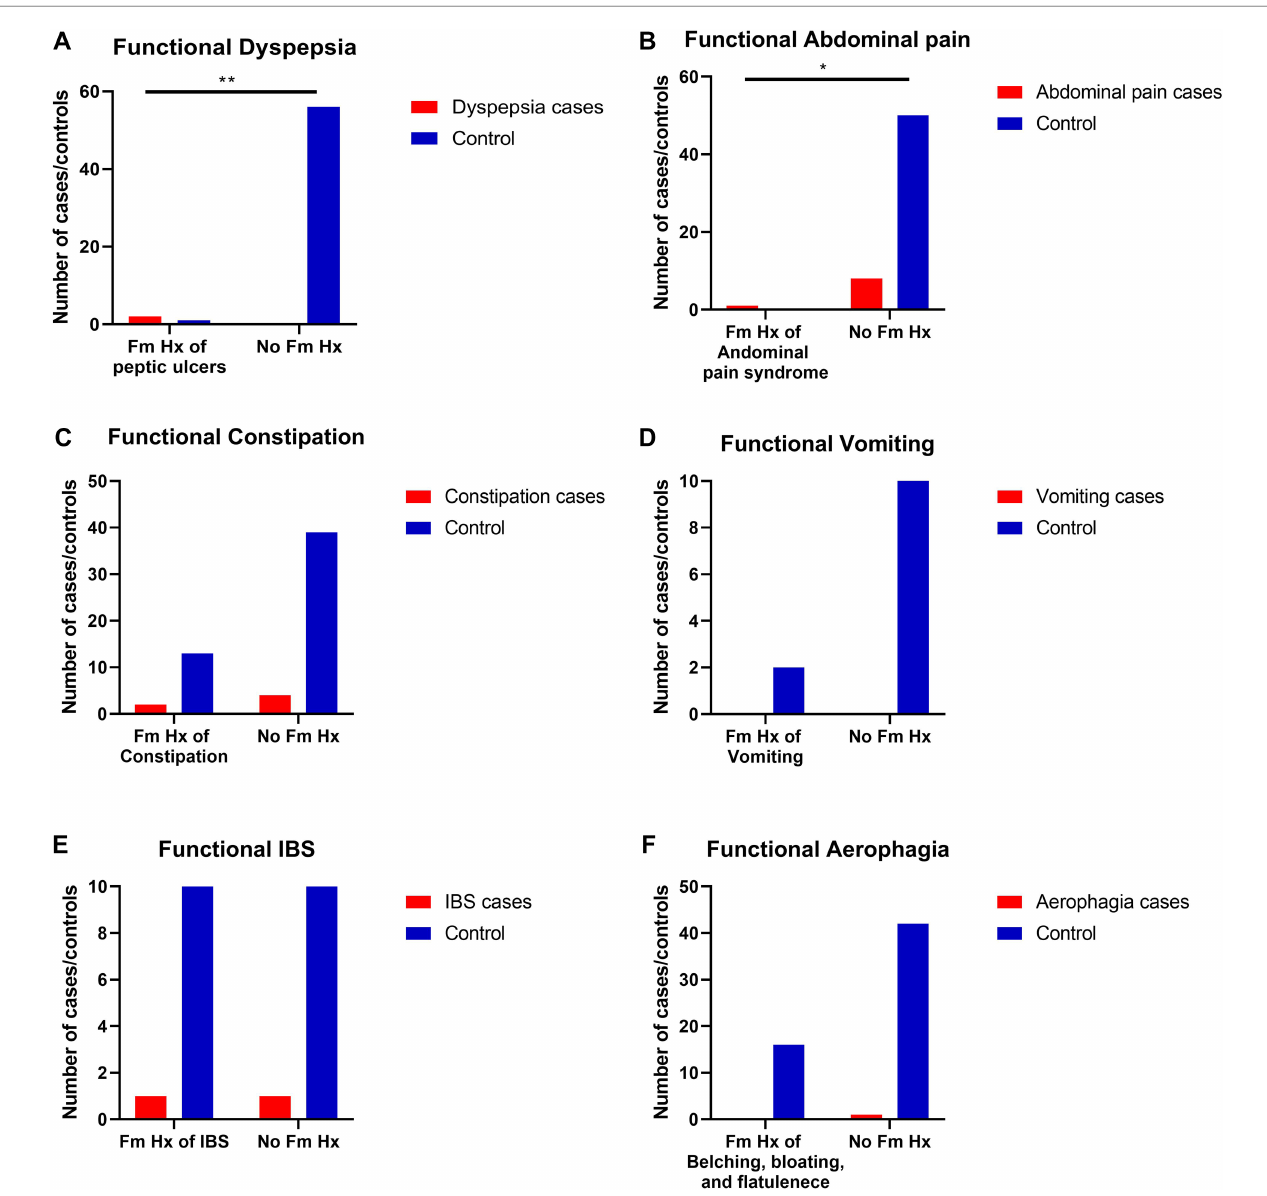
FIGURE 3 The relationship between FGIDs and some common foods consumption. Data represent frequency ( n =59) of ( (cid:129) ) cases and ( (cid:129) ) controls of ( A ) FGIDs and legume consumption, ( B ) FGIDs and cruciferous vegetables consumption, ( C ) FGIDs and fried foods consumption, (D FGIDs and spicy foods consumption, ( E ) FGIDs and cow milk consumption, ( F ) FGIDs and ice-cream consumption, ( G ) FGIDs and fi zzy drinks consumption, and ( H ) FGIDs and red meat consumption. Chi-square test was used to test the relative risk of common food consumption on developing discomfort GI symptoms in cases of children with FGIDs. Data at which values differed signi fi cantly, * p ≤ 0.05, ** p ≤ 0.01, *** p ≤